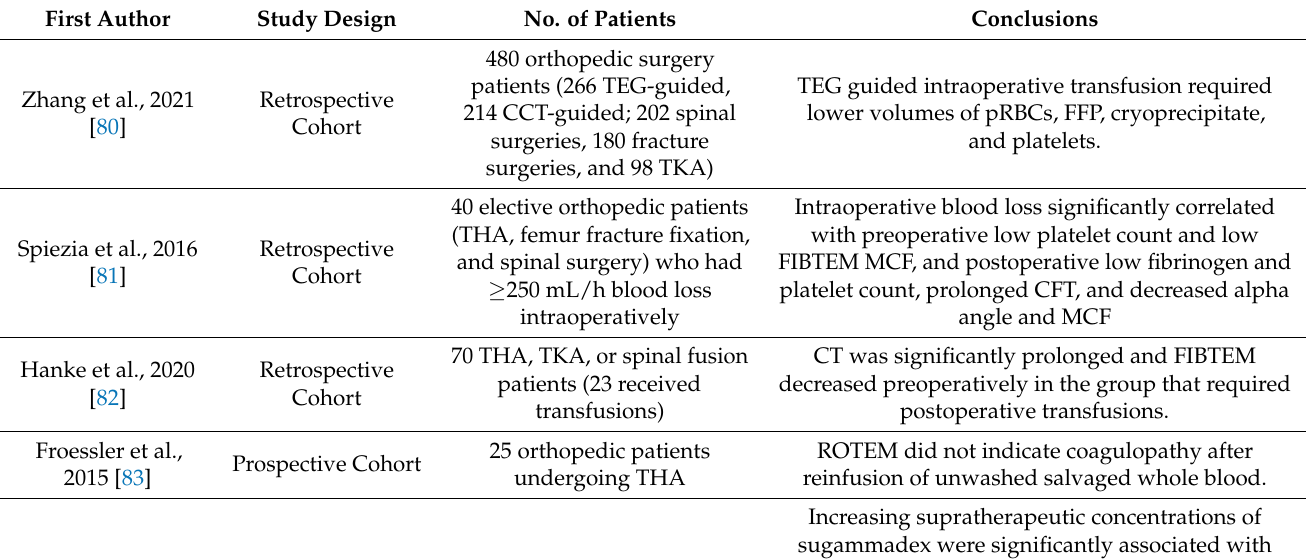
Table 7. Summary of the literature pertaining to viscoelastic hemostatic assays applied to the intraoperative conduct of patients undergoing elective orthopedic